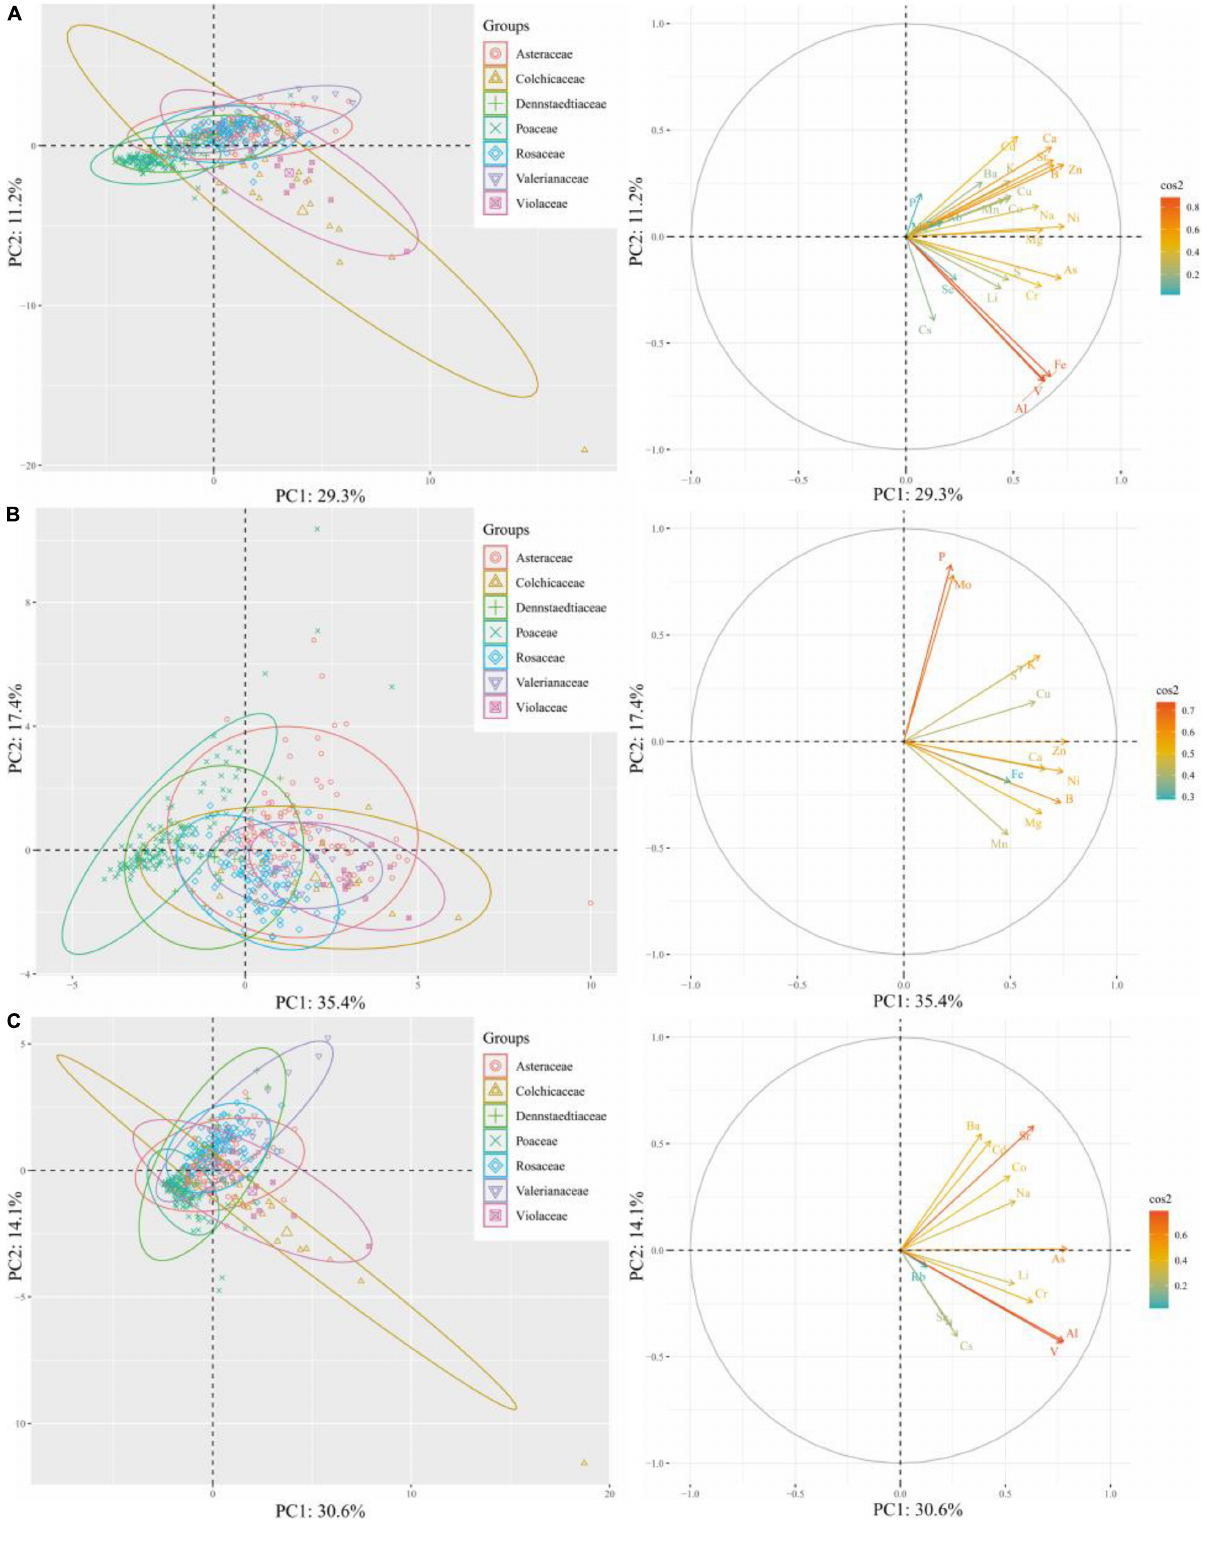
Frontiers in Plant Science |